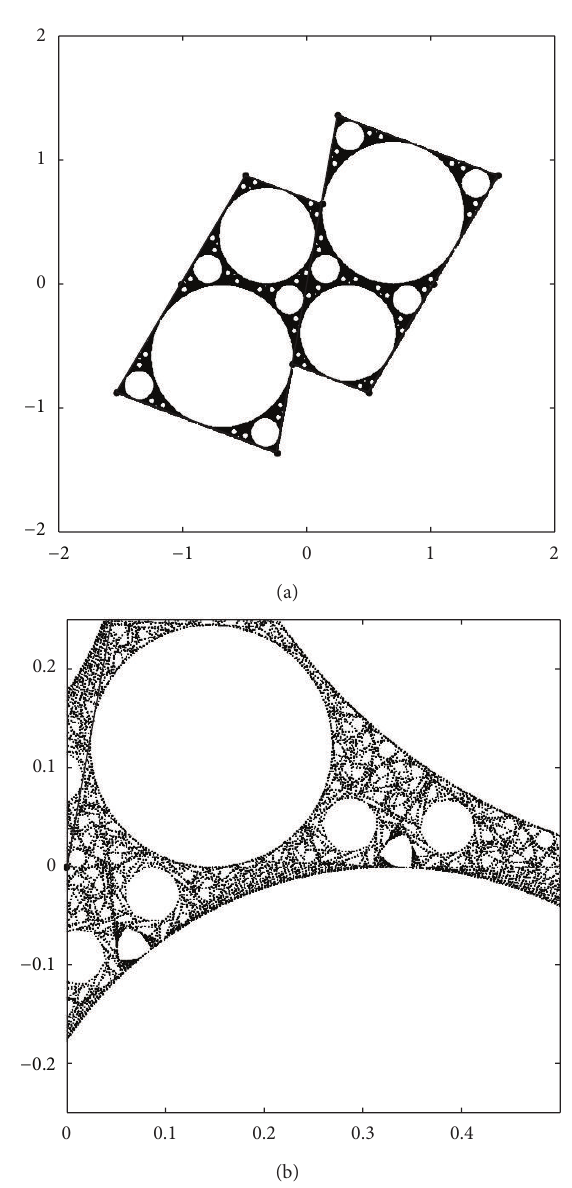
Figure 1: (a) The illustration to the invariant disks packing of the Sigma-Delta map for the parameter 𝜃 = 1.75 . (b) The local magnification of the square [0,0.5] × [−0.25, 0.25] , we can see that the disk packing is very “loose” and there is no tangencies between any pair of invariant